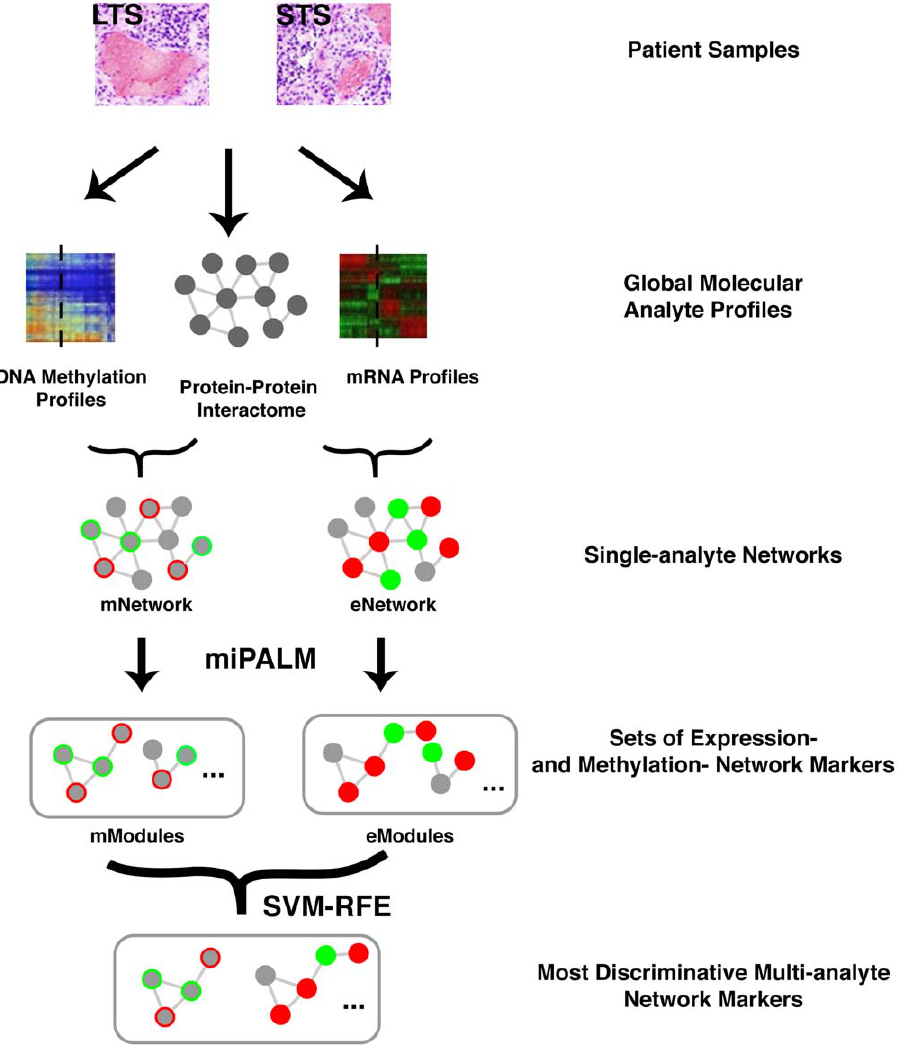
Figure 3. Overview of the MAPIT algorithm. Using clinical data, GBM patients are classified as either Long Term Survivors (LTS, . 2 yrs.) or Short Term Survivors (STS, , 2 yrs.). Two types of global measures of tumor samples are combined with protein-protein interactome (PPI) for network module identification: mRNA expression and promoter DNA methylation. Significance of change in either gene expression or promoter DNA methylation profiles between LTS and STS patients are overlaid on top of the PPI network to generate single-analyte networks, eNetwork and mNetwork. Network modules from each single-analyte network are identified using the extended miPALM algorithm [24] independently. Significant modules from each network are then combined to train a classifier for GBM prognosis using Support Vector Machine (SVM). A Recursive Feature Elimination (RFE) algorithm is implemented with the SVM classifier to select a final set of most discriminative network modules for patient prognosis.